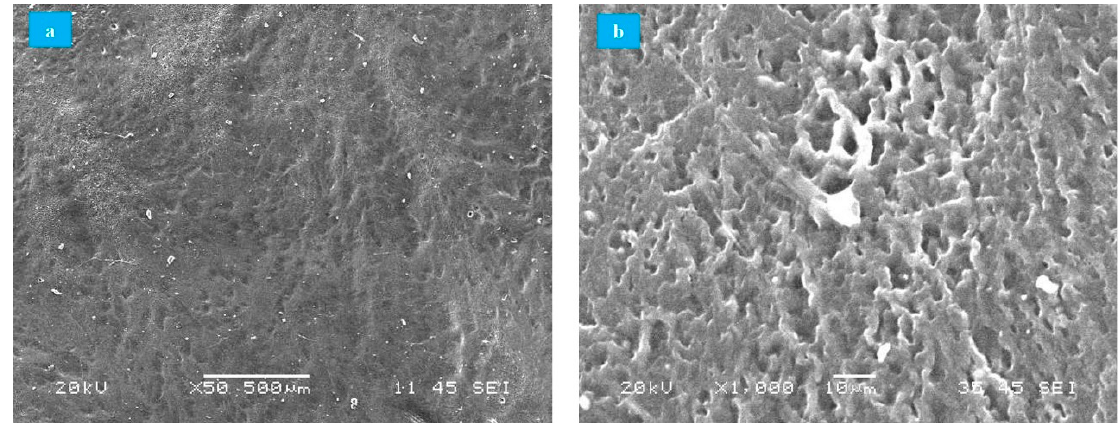
Figure 3. SEM of PVA hydrogels. ( a ) Surface distribution, ( b ) porosity (High vacuum, 50 – 1000×, secondary electrons).